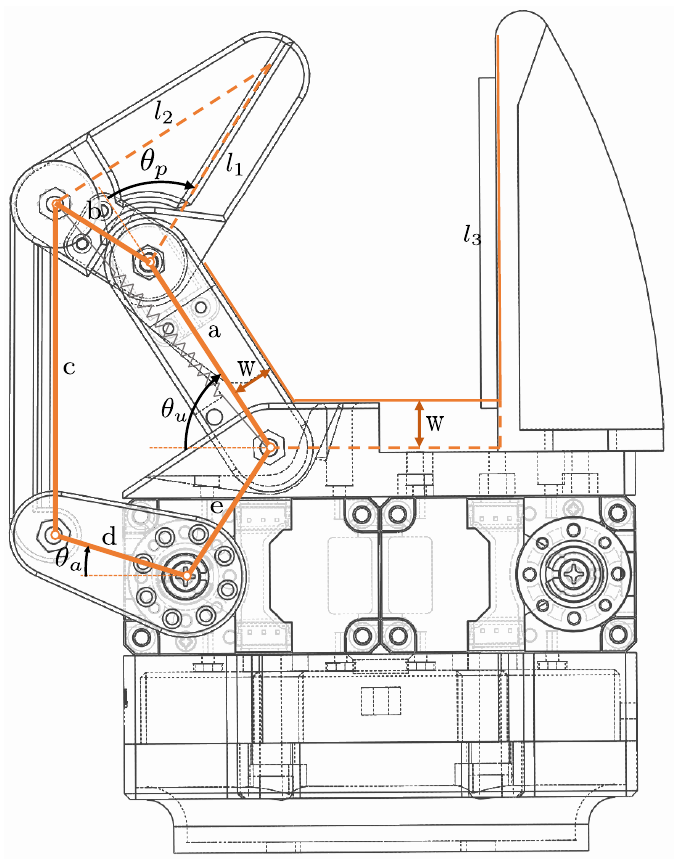
Figure 3. Kinematic design of the gripper, defining the two underactuated fingers parameters and the fixed